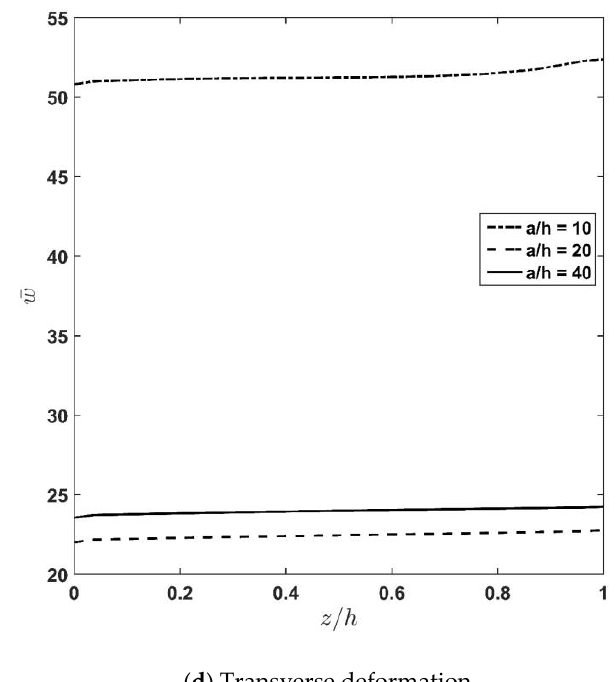
Figure 4. Influence of aspect ratio, a / h , on in-plane normal stress, transverse shear stress, and longitudinal and transverse displacement.